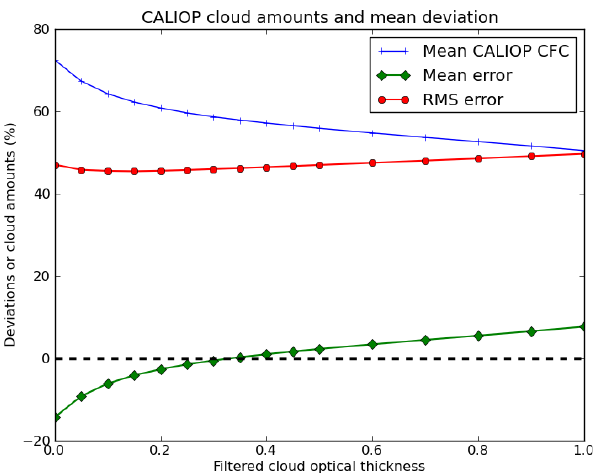
Fig. 4. Mean CALIOP cloud occurrences (CFC), mean error and RMS error as a function of filtered cloud optical thickness (ex- plained in text) for CLARA-A1/PPS cloud masks calculated from 99 global matches of NOAA-18 with CALIPSO between Octo- ber 2006 and December